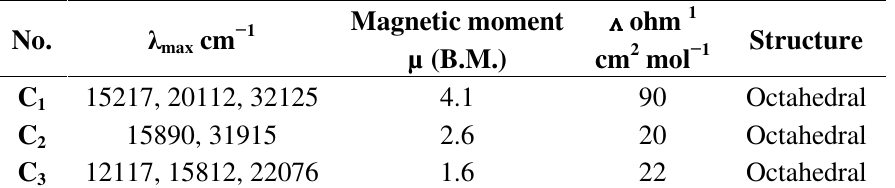
Table 4. Physical data of the synthesized